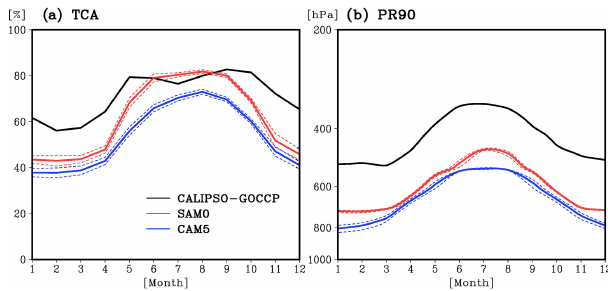
Figure 1. Annual cycles of the (a) total cloud fraction (TCA) and (b) height at which the ratio of ice condensate mass to total con- densate mass is 90% (phase ratio, PR90) averaged over the Arc- tic area, north of 65 ◦ N from CALIPSO-GOCCP observations av- eraged from June 2006 to November 2010 (black line), SAM0 (red line), and CAM5 (blue line). The dashed lines denote the standard deviations of the variables. The CALIPSO-GOCCP observations were averaged from June 2006 to November 2010, and the model results are the means of AMIP simulation results for 36 years from January 1979 to February 2015.